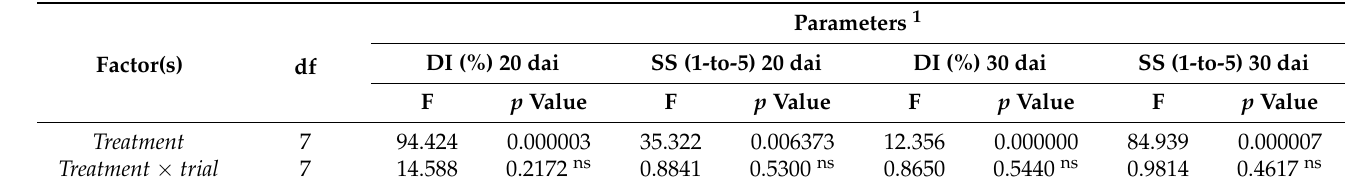
Table 5. Analysis of variance for disease incidence and severity over time (after 20 and 30 days) among eight different biological and chemical treatments in two trials.